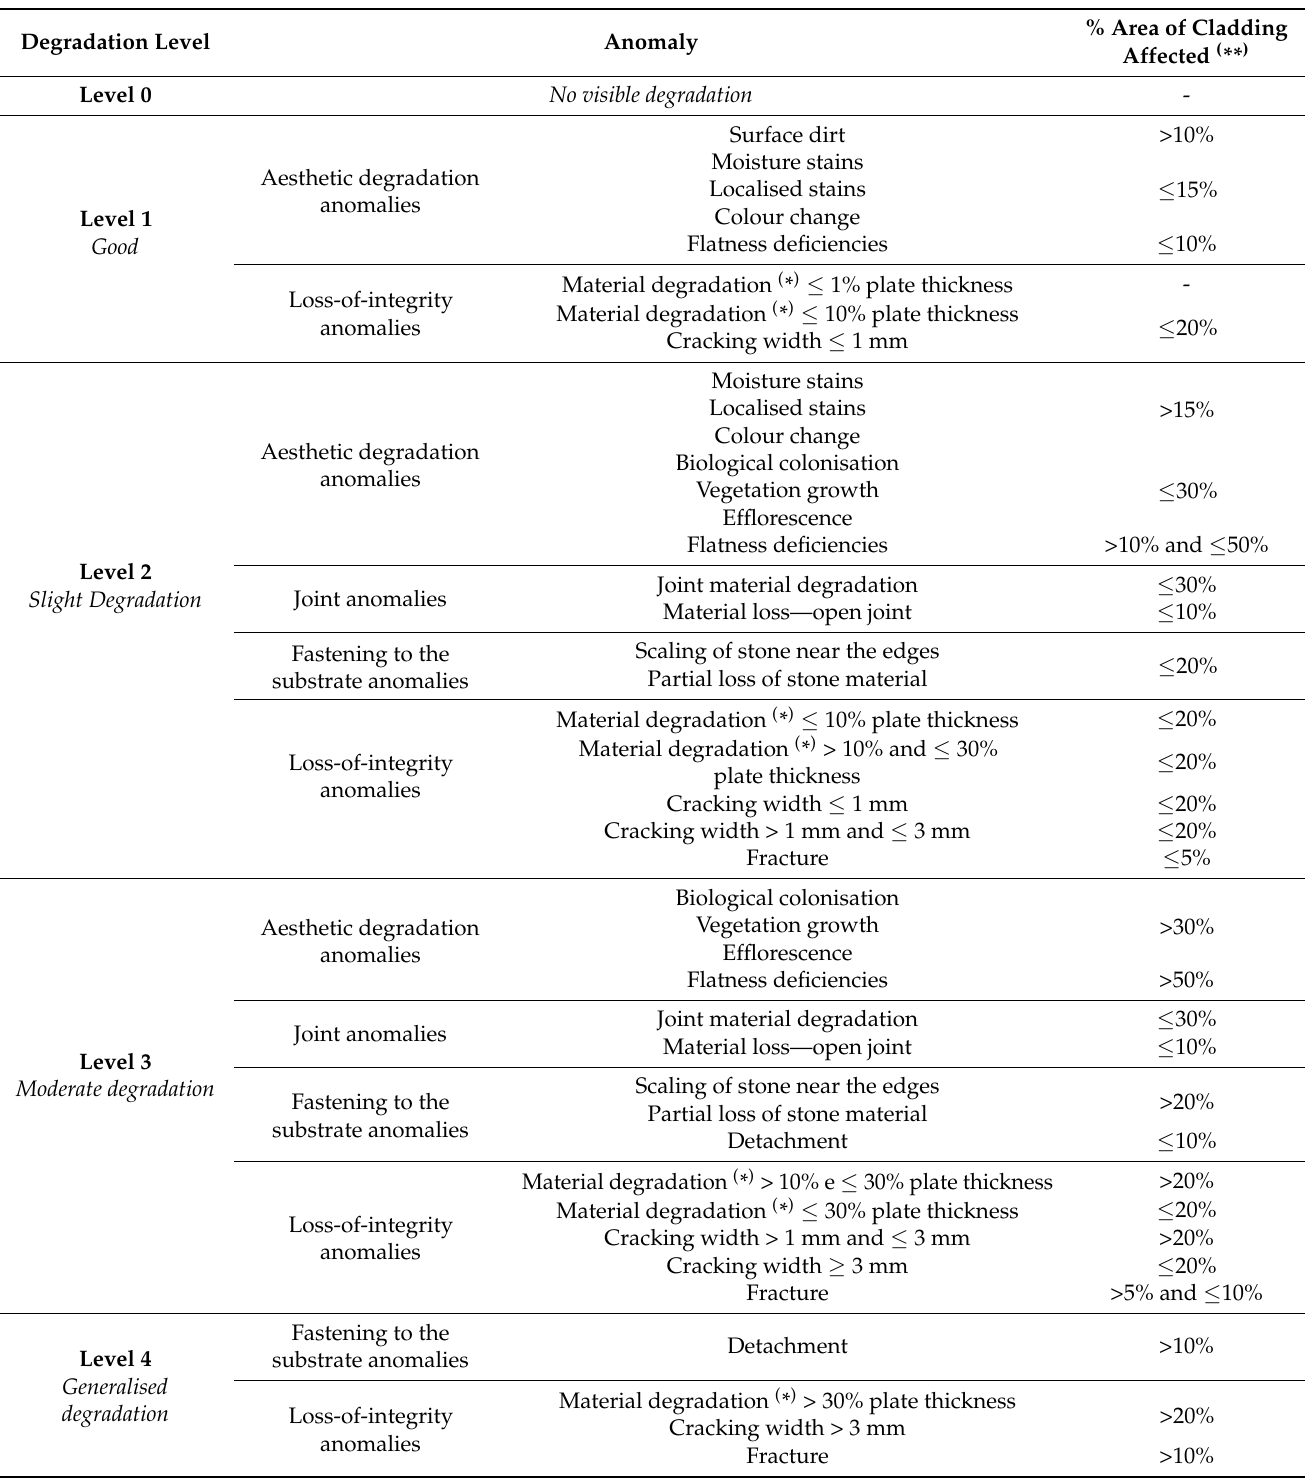
Table 2. Classification of the degradation condition of natural stone claddings (data sourced from Silva et al.